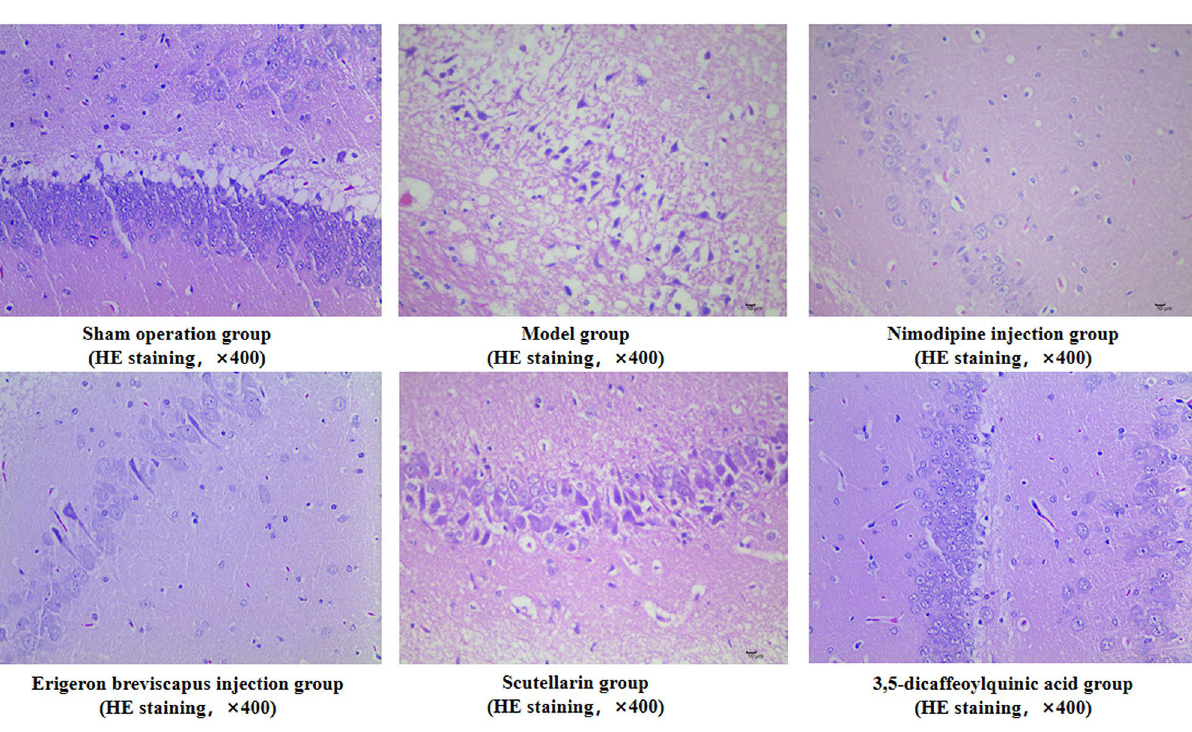
Figure 5. Histopathological changes of ischemic brain in rats: ① in each group, 400-fold images were collected from one area according to tissue size and expression; and ② the arrow indicates that 1 is normal vertebral cells and 2 is degenerated vertebral cells (Scale bar: 10 μm.)